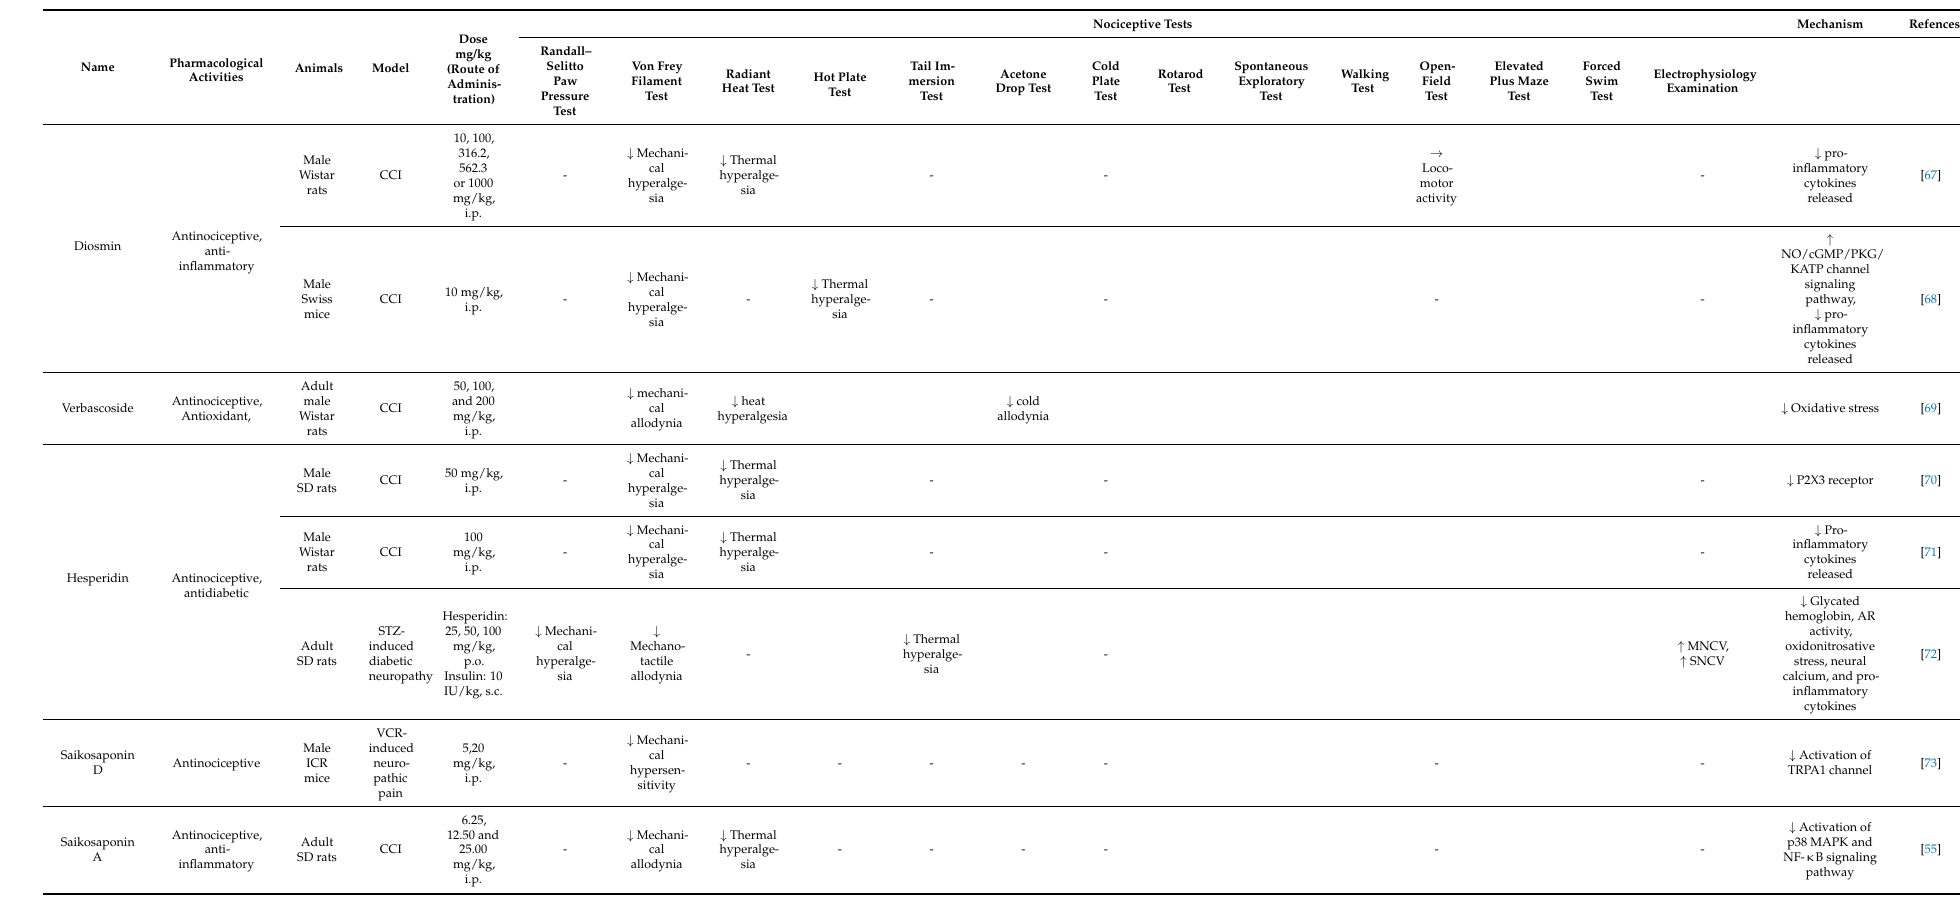
Table 3. Pharmacological activities, behavioral experiment results and mechanisms of